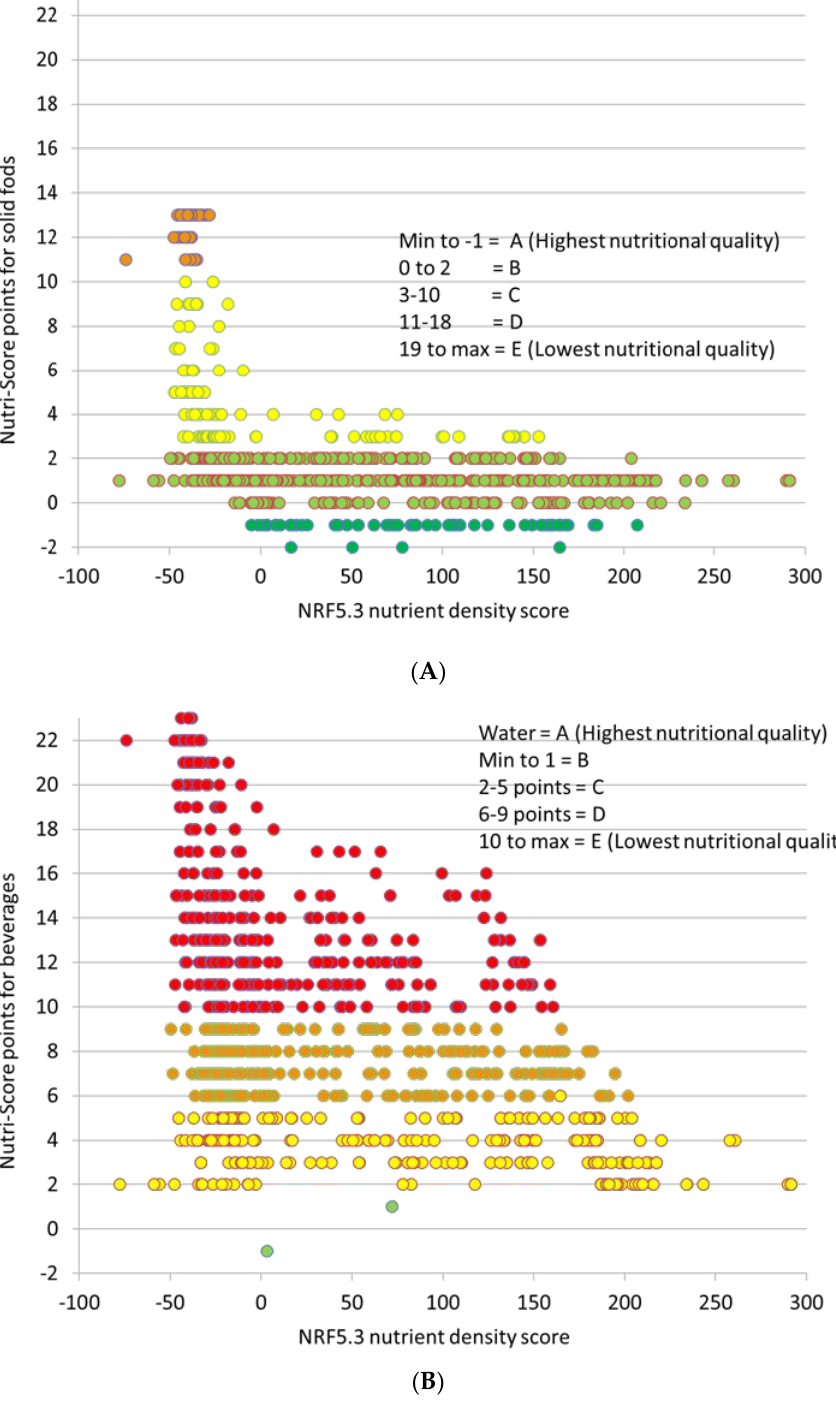
Figure 4. Plant-based beverages (milk alternatives and waters) rated using Nutri-Score for solid foods ( A ) and beverages ( B ). Nutri-Score points are plotted against NRF5.3 scores.